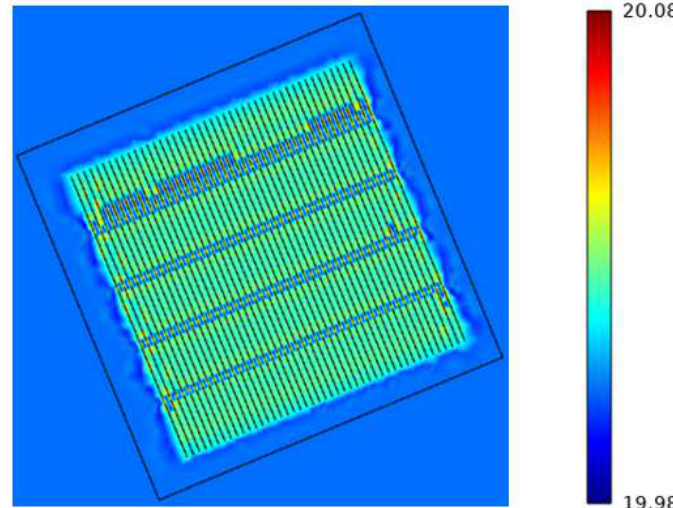
Figure 9. Temperature distribution in the coil model.